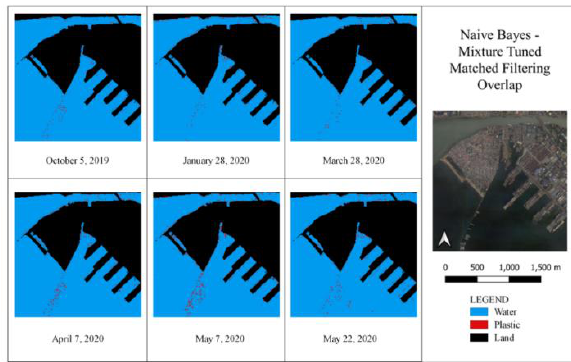
Figure 7 . Overlap of Naive Bayes and Mixture Tuned Matched Filtering Classification results.